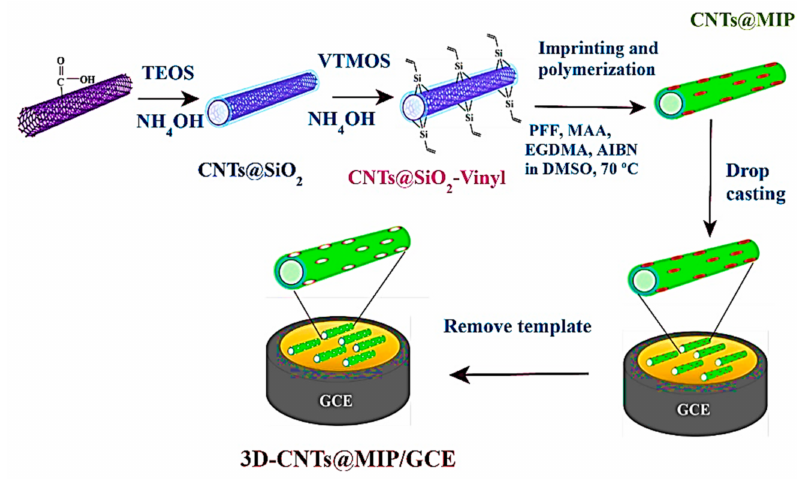
Figure 10. Schematic representation of the 3D-CNTs@-MIP preparation and further fabrication of the MIP sensor. Reproduced with permission of Elsevier from [105].